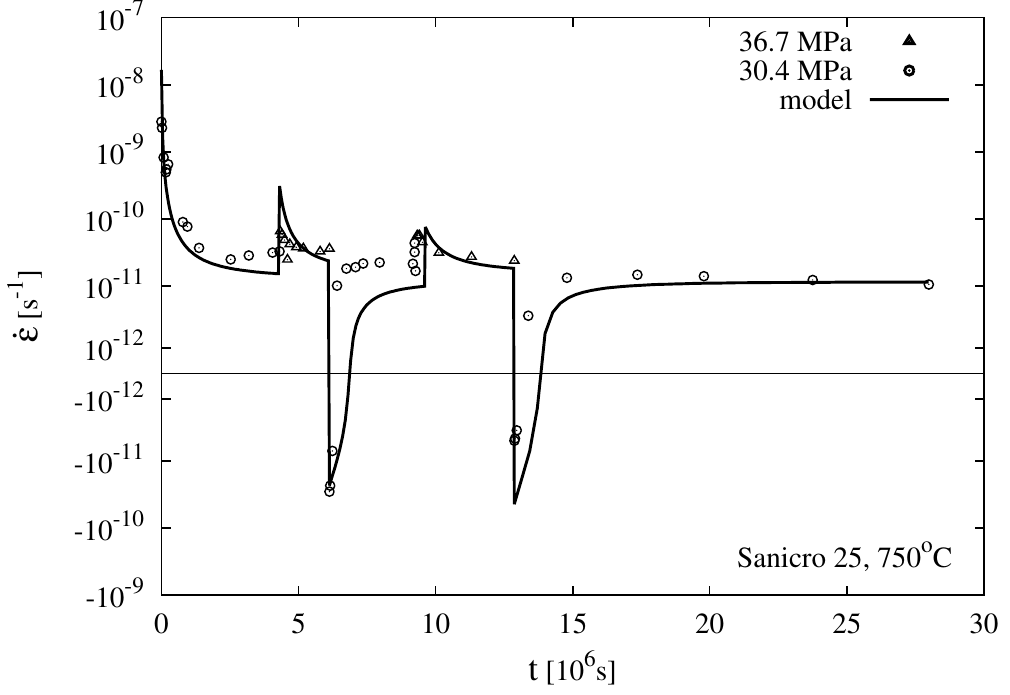
Figure 9. Creep rate dependence on time for Sanicro 25 at 750 ◦ C and stress changes (points) compared to model results